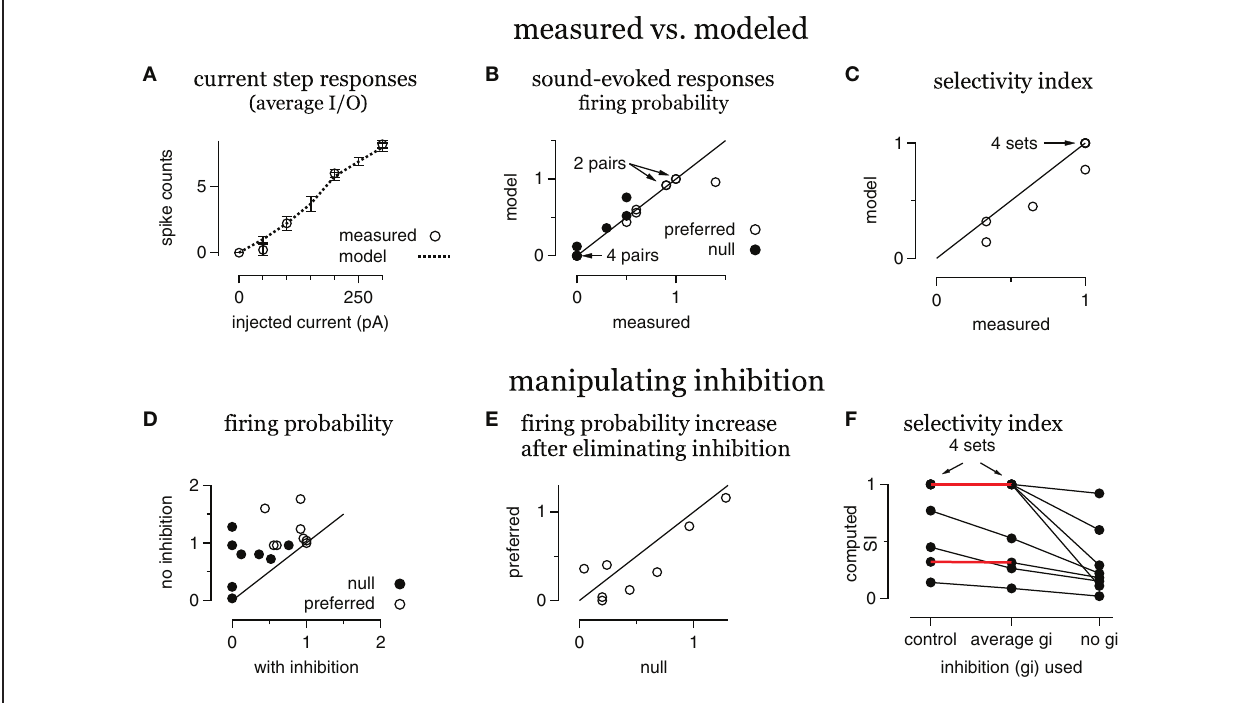
spikes/trial following the elimination of inhibition. The change is equal to the spikes/trial under control conditions with inhibition intact subtracted from the spikes/trial with no inhibition. (F) Selectivity index computed using either the control conductance sets, conductance sets with the average inhibition and the control excitations, or with the control excitations only. Red lines indicate no change in SI using the average